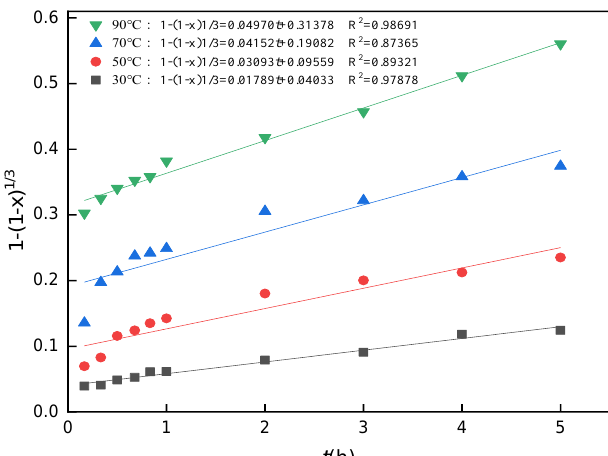
Figure 17. Relationships between 1 − 2/3x − (1 − x) 2/3 and time of iron ions.